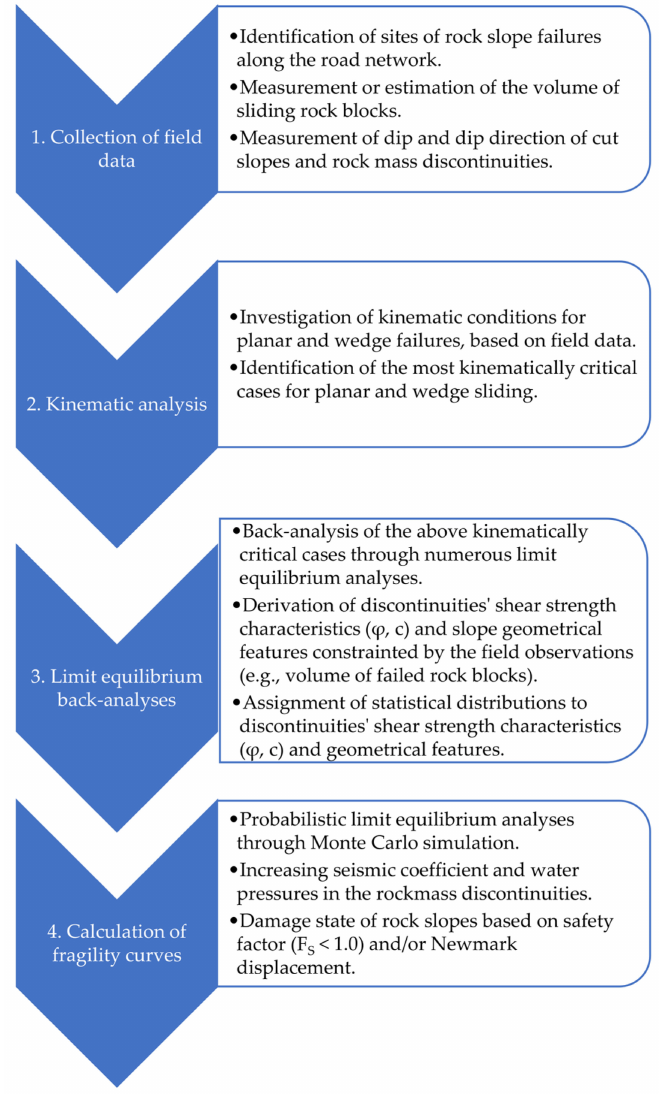
Figure 1. General workflow adopted in the present study to derive fragility curves of rock slopes at a regional